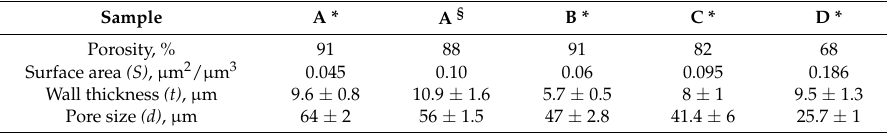
Table 1. Characteristics of the porous structure of HEMA-AGE gel samples A, B, C and D. Sample A *